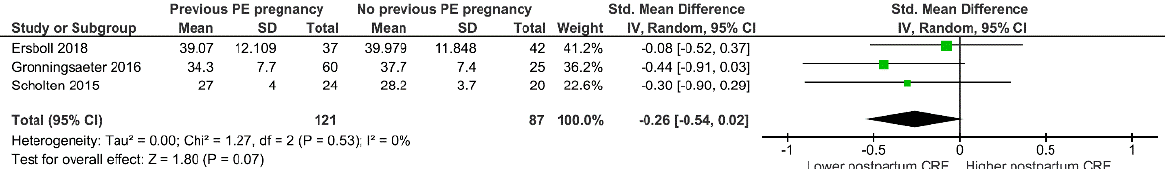
Figure 2. Mean differences in VO 2 max during pregnancy and subsequent development of preeclampsia and/or gestational hypertension: ( a ) Weight-adjusted VO 2 max (in mL/kg/min) and preeclampsia or gestational hypertension [19,28]; ( b ) Weight-adjusted VO 2 max (in mL/kg/min) and preeclampsia [19,28,29]; ( c ) Weight-adjusted VO 2 max (in mL/kg/min) and gestational hypertension [19].